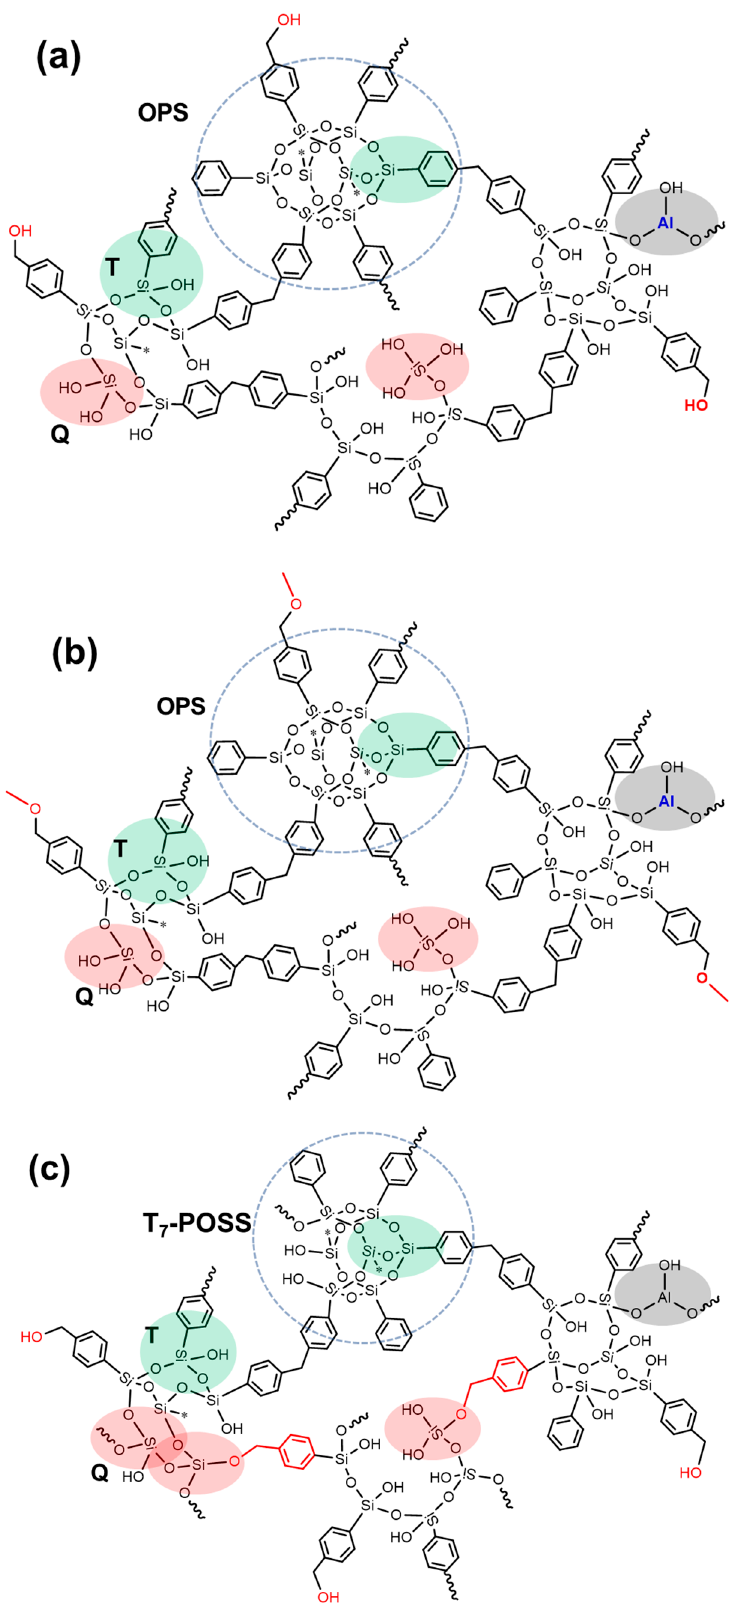
Figure 7. The expected chemical structure of the porous materials: ( a ) sample A, ( b ) sample B, and ( c ) sample C.